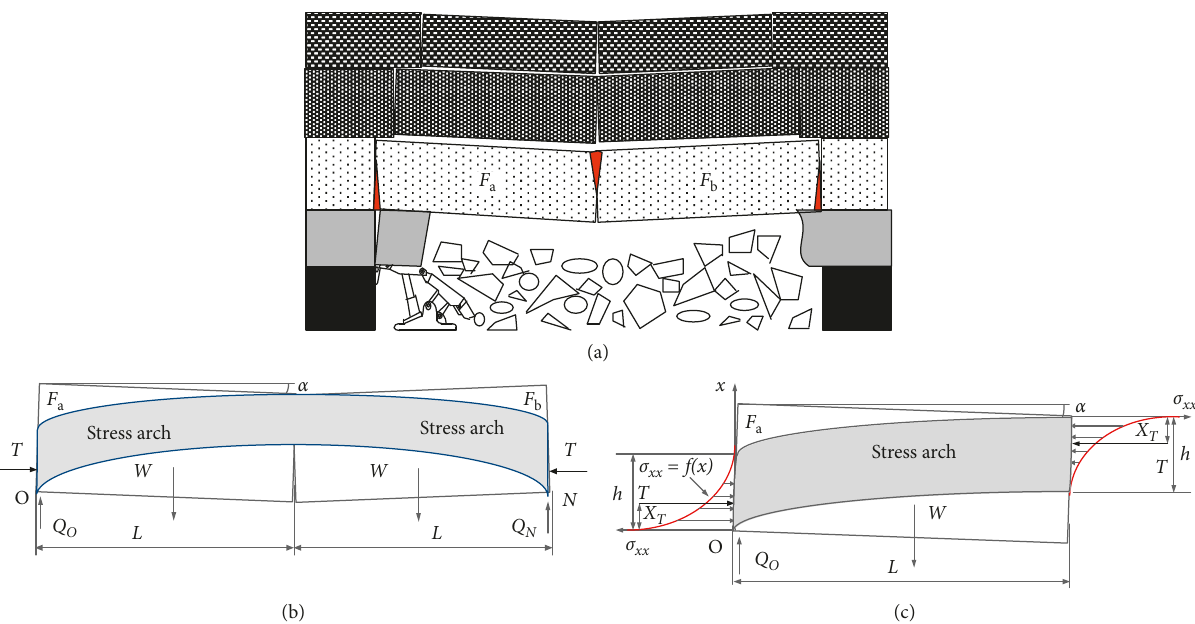
Figure 2: Pressure-arch structure of two key blocks of the initial fractured roof. (a) Sketch map of the structure of key blocks. (b) Mechanical model. (c) Boundary stress distribution at the